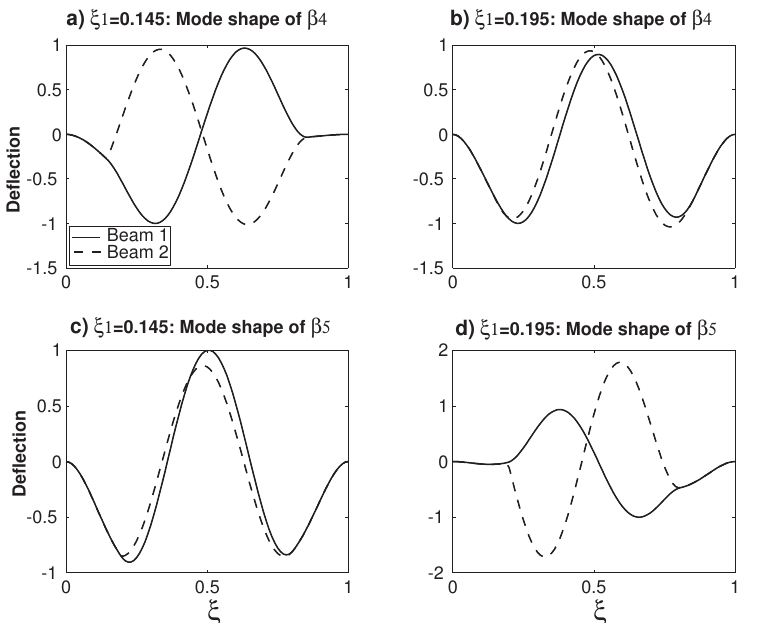
Figure 5. The changes of the mode shapes before and after a veering locus. ( a ) The β 4 mode shape at ξ 1 = 0.145 and ( b ) the β 4 mode shape at ξ 1 = 0.195. ( c ) The β 5 mode shape at ξ 1 = 0.145 and ( d ) the β 5 mode shape at ξ 1 = 0.195.